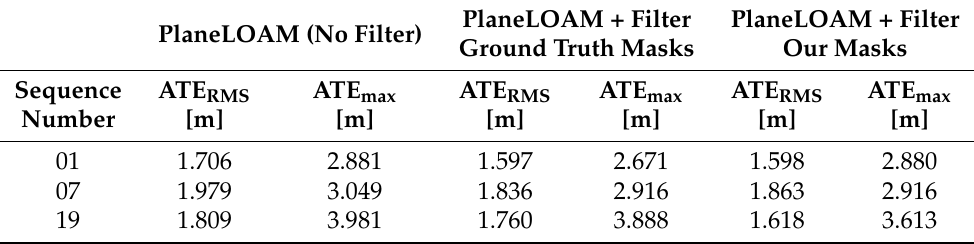
Table 3. Comparison of ATE errors for trajectories computed by three configurations of PlaneLOAM for the selected sequences from the KITTI MOTS